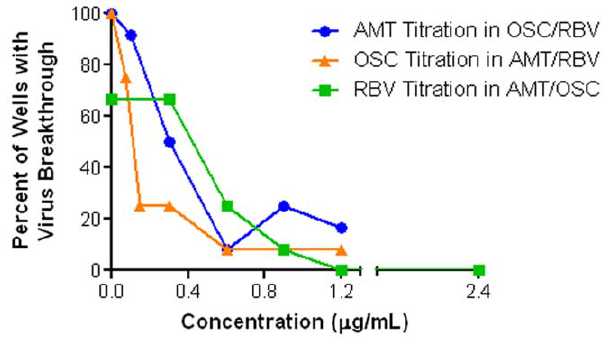
Figure 4. Each Drug in TCAD Contributes to the Suppression of Virus Breakthrough. MDCK cells in 96-well plates were infected with influenza A/Hawaii/31/2007 (H1N1) virus in the presence of a combination of two drugs at fixed concentrations with varying concentrations of the third drug, using 12 replicates for each condition. The fixed concentrations of the double combinations were 0.30 m g/mL OSC and 0.60 m g/mL RBV, 0.6 m g/mL AMT and 0.6 m g/mL RBV, or 0.6 m g/mL AMT and 0.3 mg/mL OSC. Following 5 serial passages, the number of wells for each condition having virus breakthrough, defined as . 50% cytopathic effect, was determined by neutral red uptake.